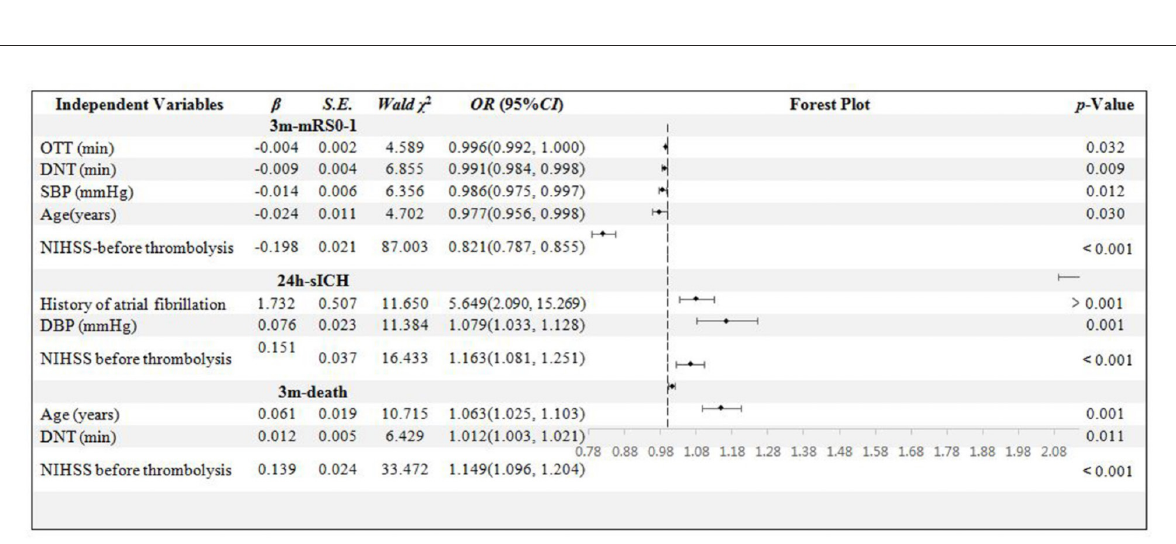
FIGURE4 Binary logistic regression analysis in age < 80 years group. OTT, onset to thrombolysis time; DNT, door to needle time; SBP, systolic blood pressure; DBP, diastolic blood pressure; mRS, modified Rankin scale; sICH, symptomatic intracranial hemorrhage; NIHSS, National Institute of Health stroke